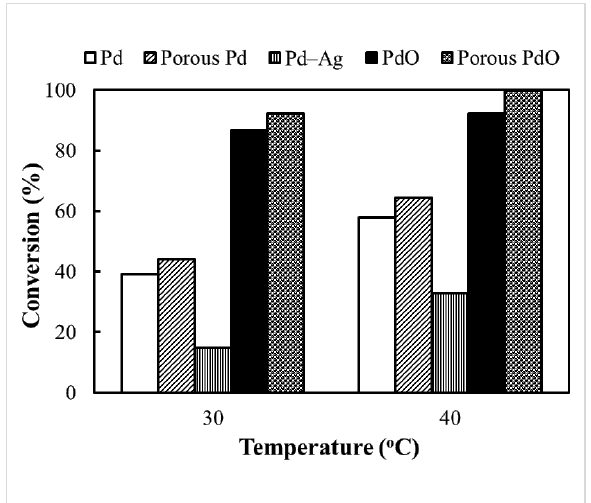
Figure 3: Influence of temperature on the conversion of 0.01 M p -nitro- phenol with 0.1 M formic acid at 30 °C and 40 °C. Tubular reactors coated with Pd, PdO, Pd–Ag, porous Pd or porous PdO were applied for demonstration of the catalytic activity. All experiments were conducted with 14.7 s residence time.